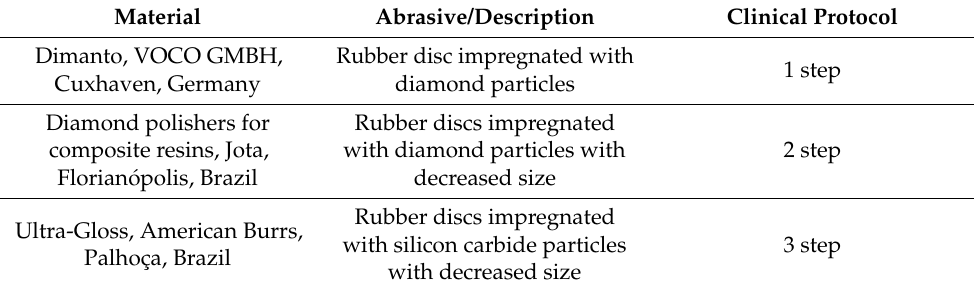
Table 2. Specifications of the polishing systems tested. Material